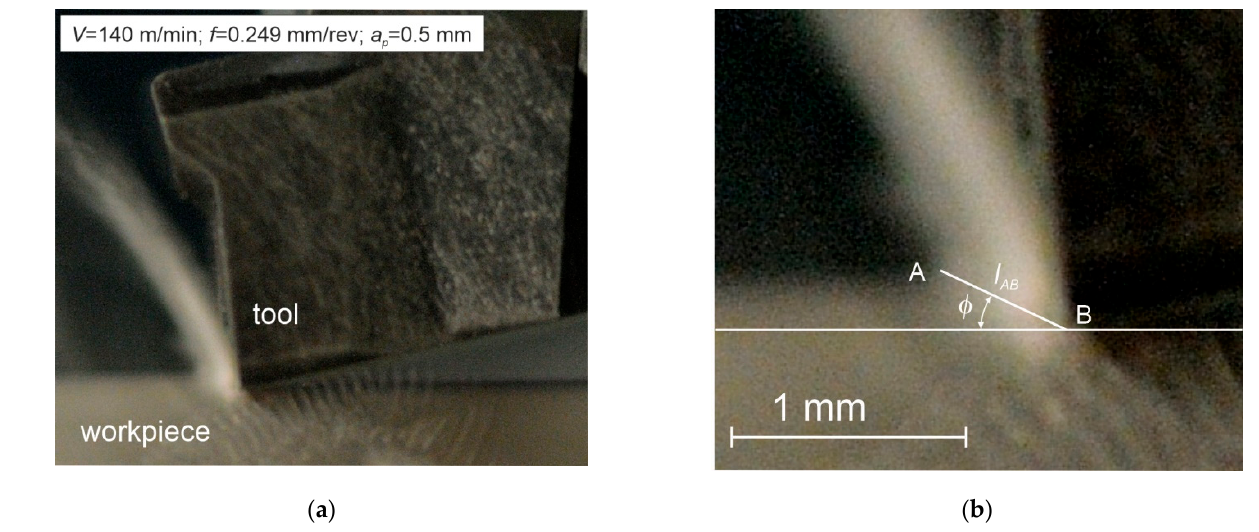
Figure 5. ( a , b ) Examples of the chip forming photographs for V = 140 m/min, f = 0.249 mm/rev, a p = 0.5 mm .